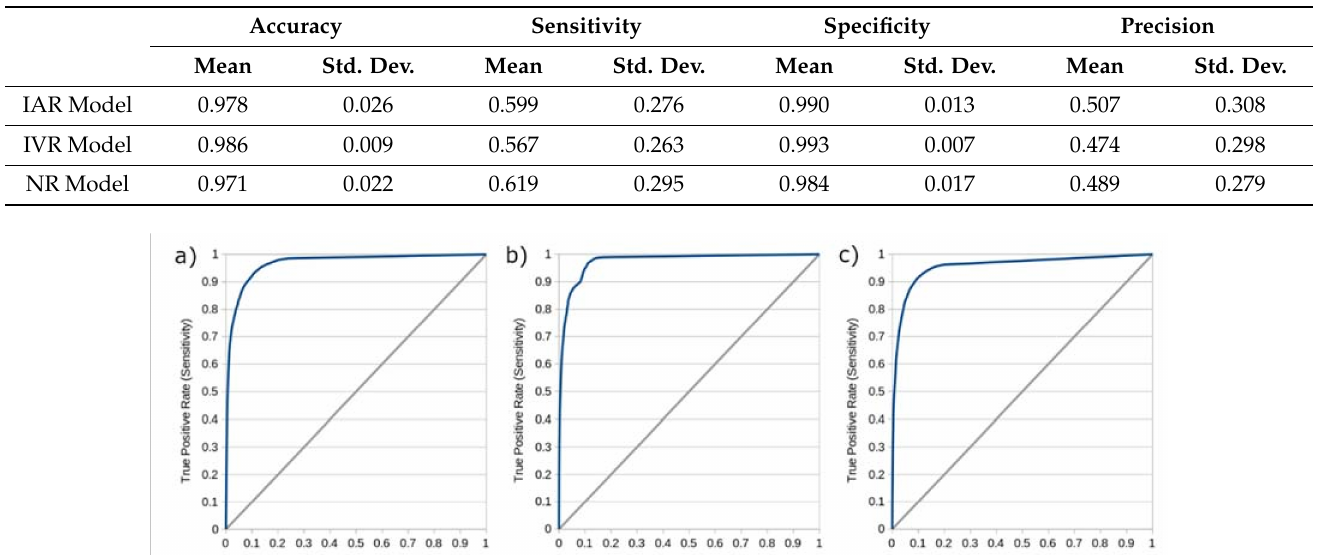
Table 2. Additional statistics derived from the confusion matrices comparing each model’s standard predictions and the corresponding follow-up lesion segmentations. Recanalization outcomes are abbreviated IAR (intra-arterial therapy, recanalizing), IVR (intravenous tPA, recanalizing), and NR (non-recanalizing).